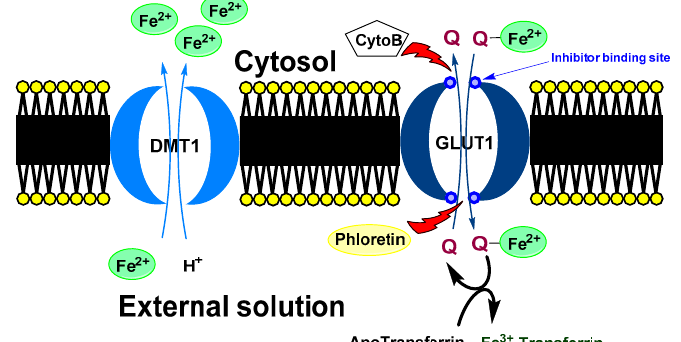
Figure 5. Possible mechanism of quercetin effect on intracellular iron homeostasis. Ferrous ions are usually transport to a cell by DMT1. In the cytosol, quercetin can chelate iron ions. Formed complex is transported out the cell via GLUT1. In the opposite direction, free quercetin is transported to a cell. In the extracellular space, chelated iron ion is moved from quercetin to the transferrin (blood transport protein for the ferric ions). In the shortly, quercetin can decrease intercellular concentration of iron ions. DMT1 (divalent metal transporter 1), GLUT1 (glucose transporter), Cyto B (cytochalasin B) and Phloretin (Inhibitors of GLUT1), Q (quercetin).